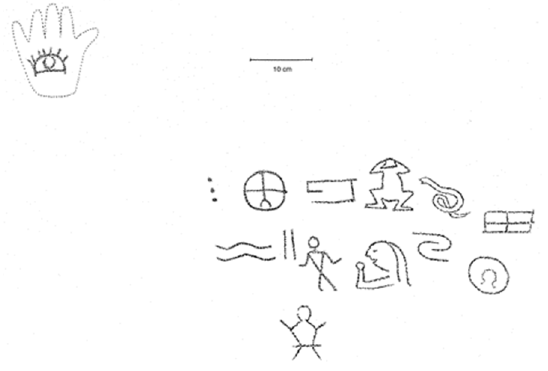
Figure 15. Ash Fork, Arizona, panel 1. Showing text with unique signifier to the upper left—a shadow of a handprint with radiant eye design inscribed in the palm (Drawing by David Lee).